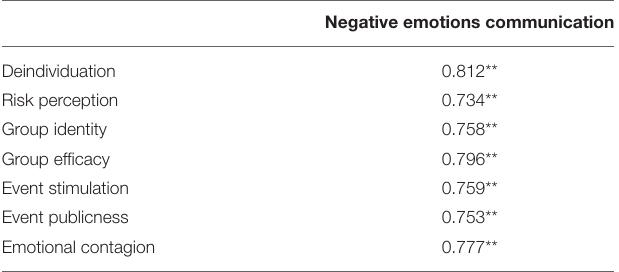
TABLE 5 | ANOVA results for age on negative emotional communication.